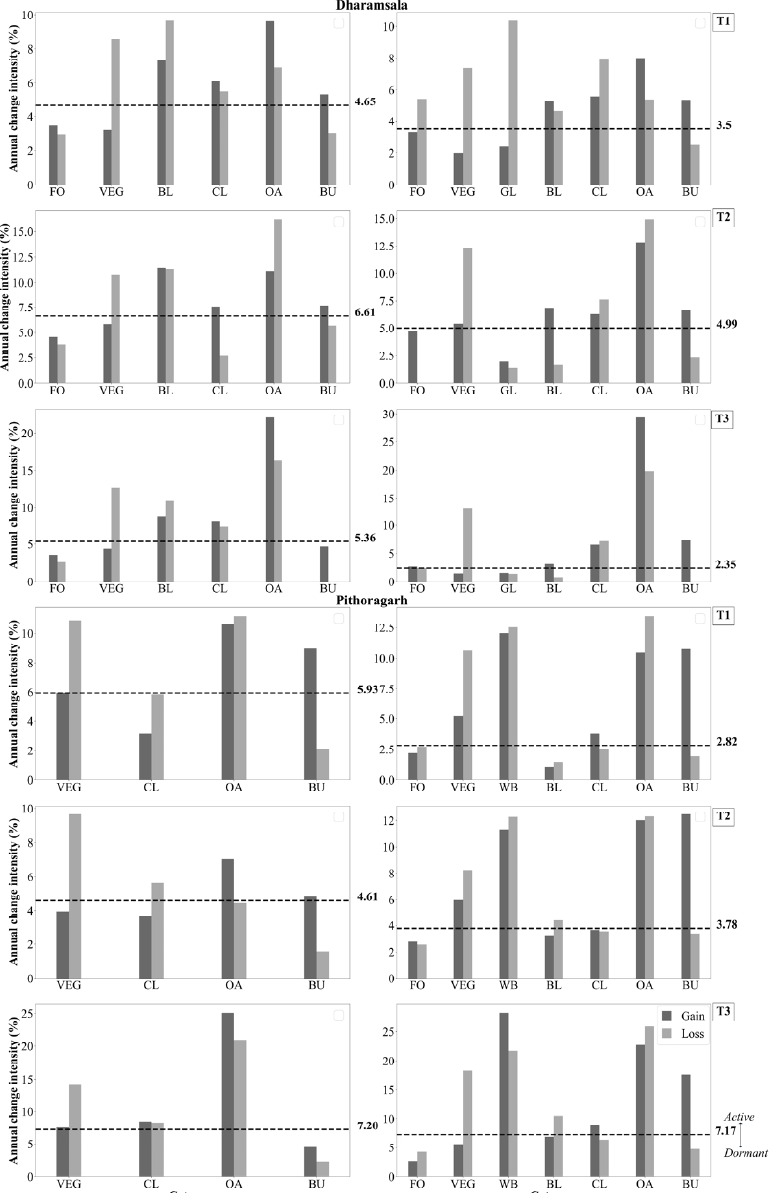
Figure 4. Category level changes in terms of intensity during three time intervals in Dharamsala and Pithoragarh, at the city level (Column 1) and outer zone (Column 2). FO: forest, VEG: vegetation, GL: glacier, WB: waterbody, BL: barren land, CL: cropland, OA: open area, and BU: built-up. The black dashed line represents the uniform intensity, and its value is placed next to it.